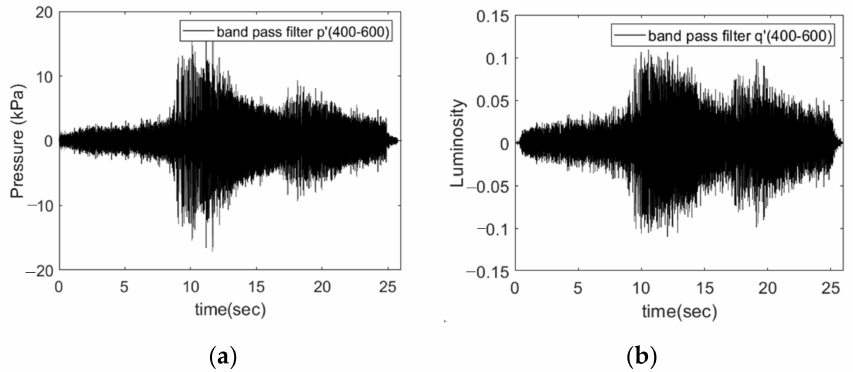
Figure 10. Filtered traces of ( a ) pressure ( p (cid:48) ) and ( b ) luminosity fluctuations ( q (cid:48) ) in test